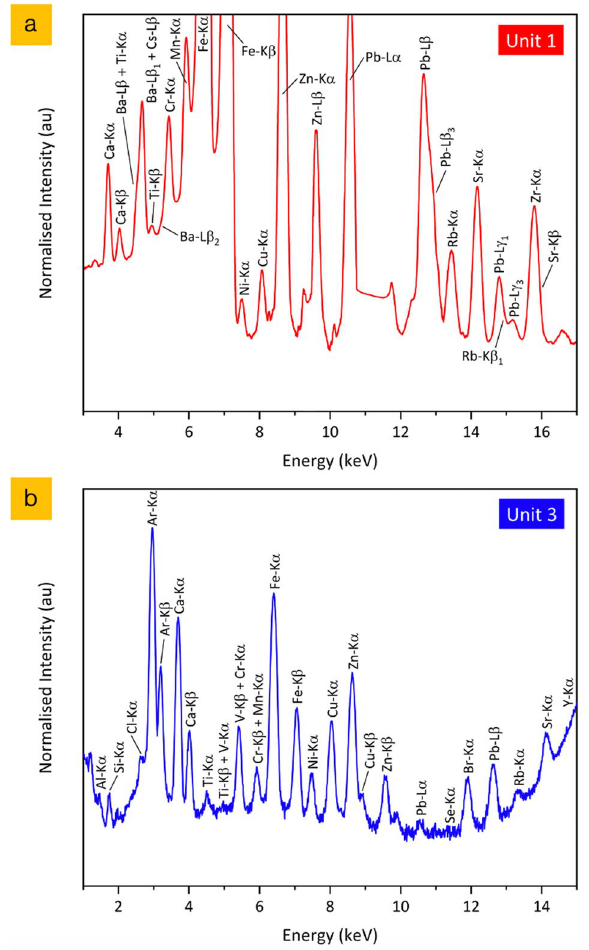
Figure 6. Synchrotron radiation XRF spectrum obtained from the entire volume of particles ( a ) CF-01-R024 (Unit 1), and ( b ) OH-06-07 (Unit 3).